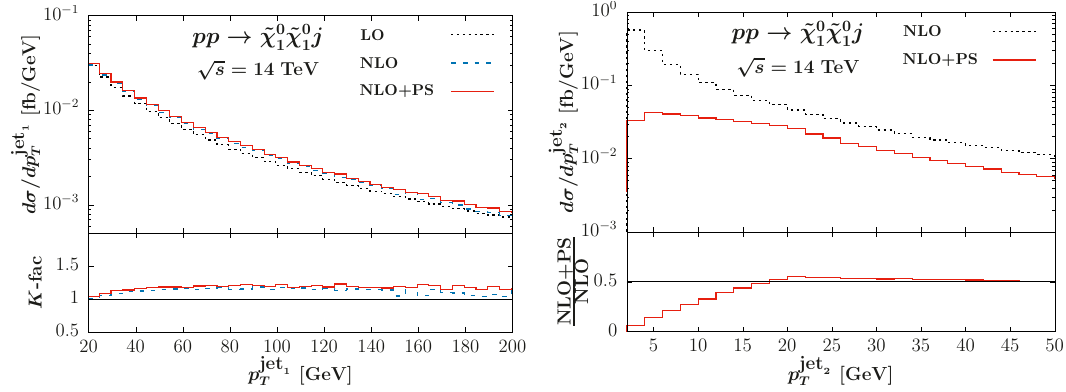
Figure 7 . Transverse-momentum distribution of the hardest jet (left) and the second hardest jet (right) for the process pp ~ (cid:31) 0 ~ (cid:31) 0 j at LO (dotted black lines), NLO (dashed blue lines), and NLO+PS 1 1 ! (solid red lines) for our default setup, after the cuts of eq. (3.5) are